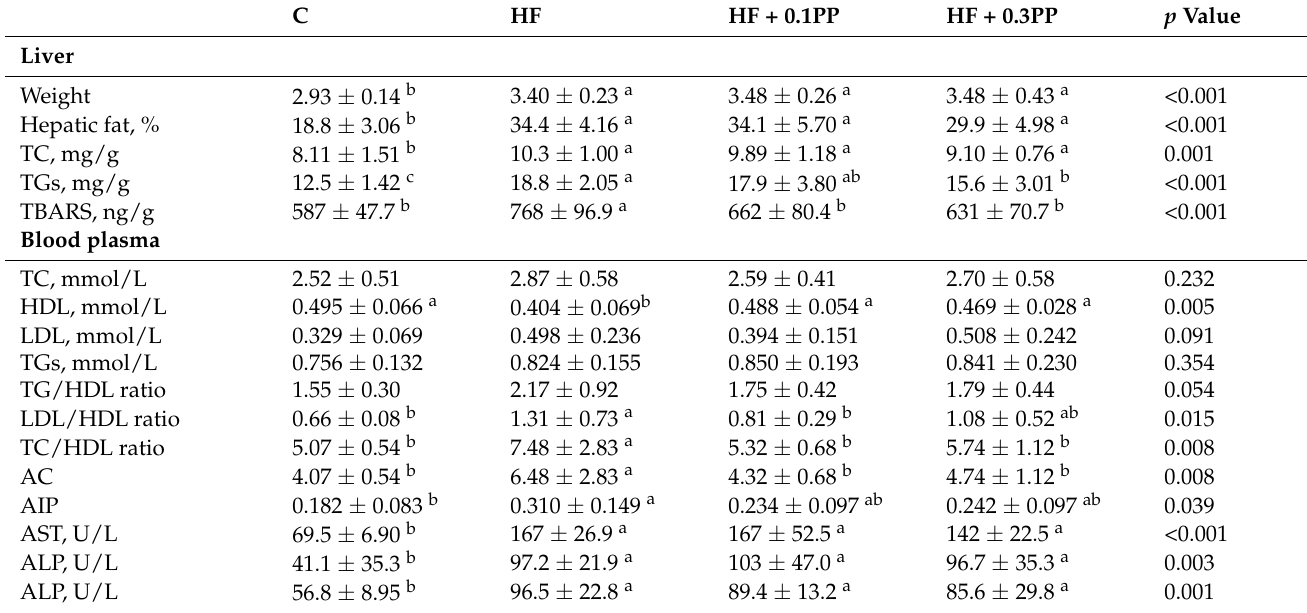
Table 5. Liver and blood plasma biochemical parameters of rats fed experimental